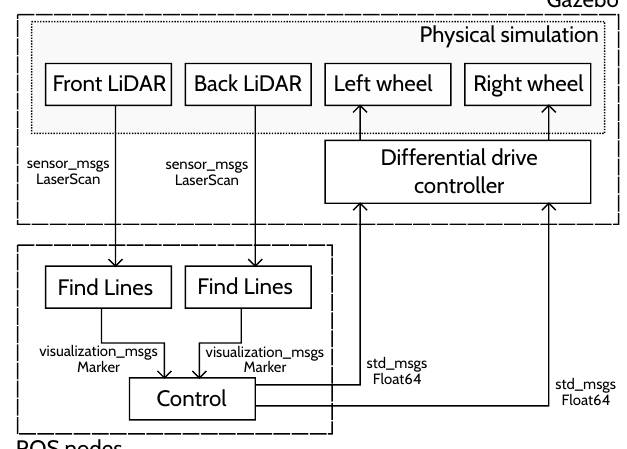
Figure 12. The simulator overview.